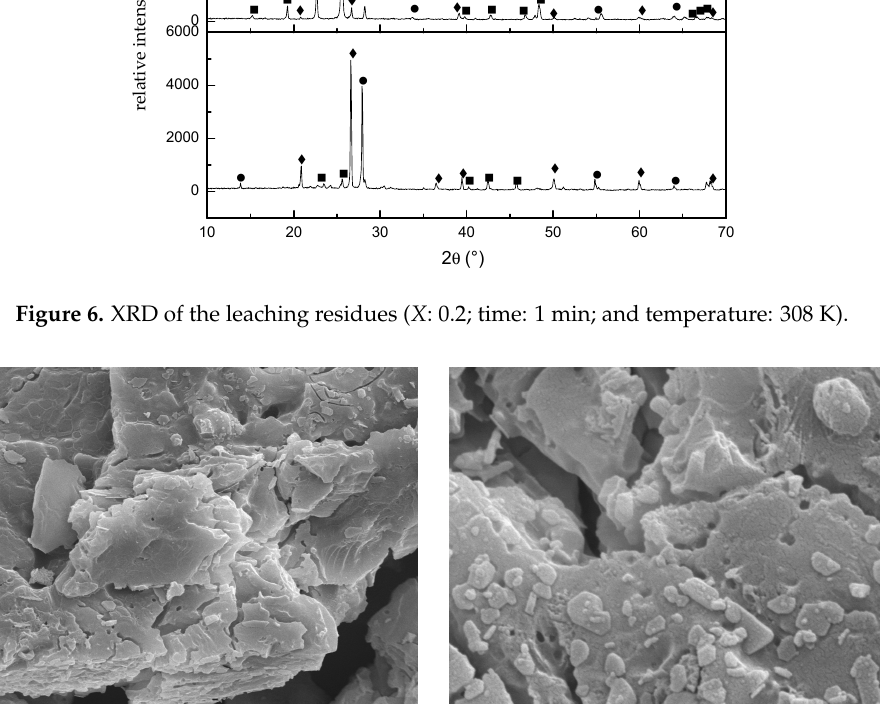
Figure 7. SEM micrographs of the leaching residue ( X : 0.04; time: 1 min; and temperature: 278 K).